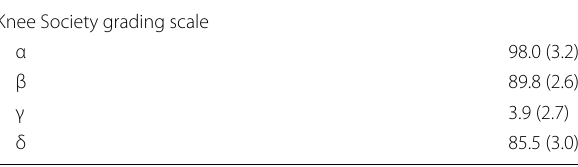
Data are reported as mean (standard deviation)